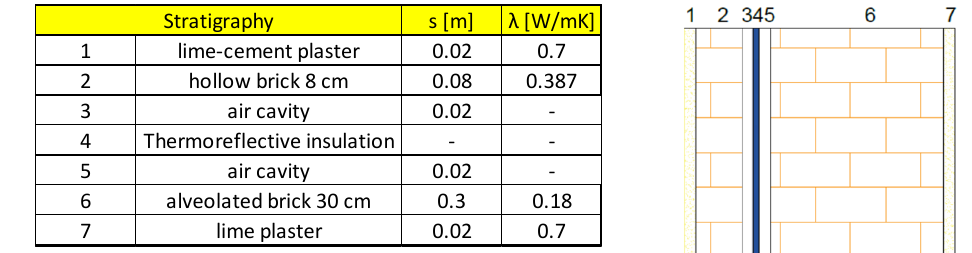
Figure A2. Wall type 1: transmittance check for the three main Italian climatic zones. In blue are the heat-reflective materials which respect all the limits.